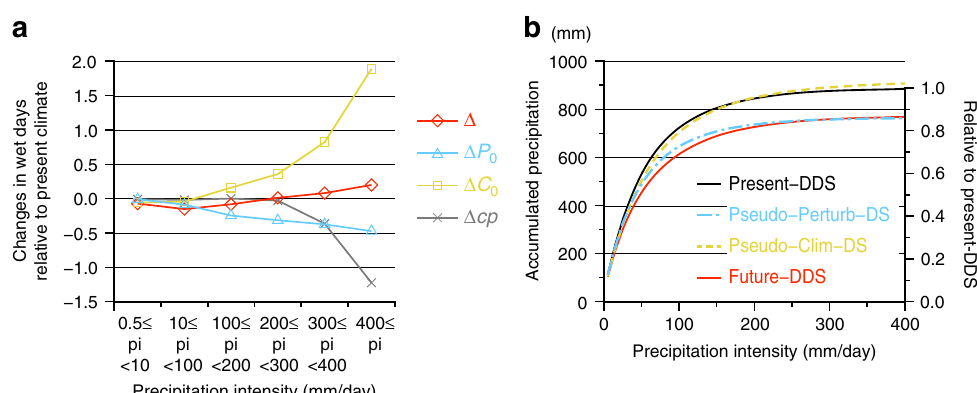
Fig. 4 Changes in precipitation characteristics for different precipitation intensities. a Difference in the number of wet days from the present climate for each category of precipitation intensity and b the cumulative precipitation amount. The value in a is normalised by the number of wet days in Present-DDS for every intensity category. Δ is the total change estimated by the DDSs (Future-DDS − Present-DDS). Δ P 0 and Δ C 0 indicate the contributions of the perturbation and climatology, respectively. Δ cp is the contribution of the nonlinear effect. The right scale in b indicates the ratio to the